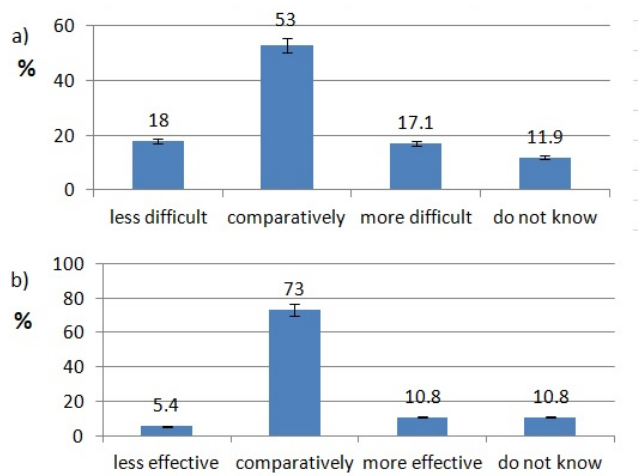
Figure 9. Computer controlled local anesthetic delivery use pattern of responding dentists; ( a ) effec- tiveness of CCLAD, ( b ) difficulty of CCLAD.